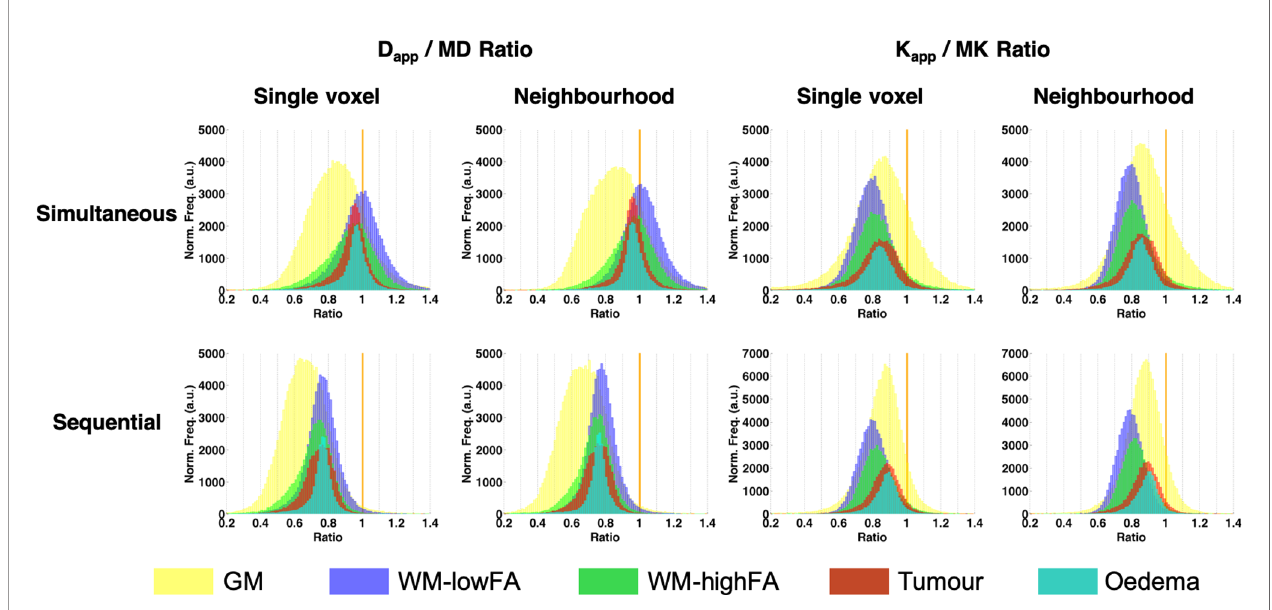
FIGURE 5 | Ratio histograms of D app /MD and K app /MK. The vertical orange line indicates a ratio of 1.